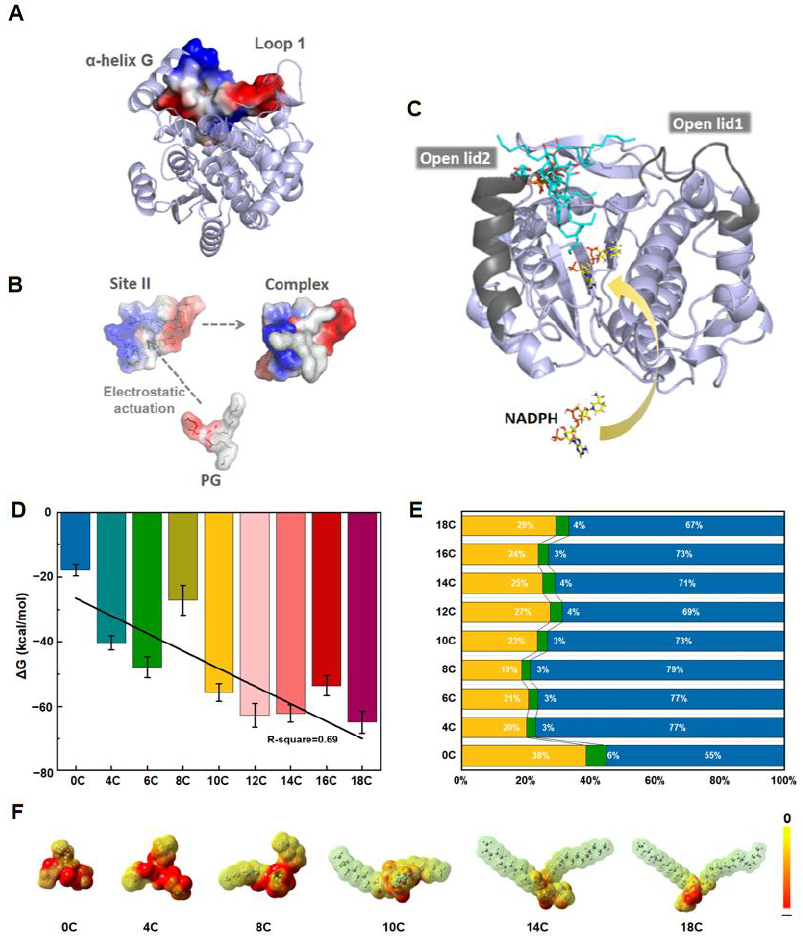
Figure 5. Electrostatic potential isosurface for ( A ) site II with the surrounding lid region, where red and blue represent positive and negative charges, respectively. ( B ) Schematic diagram of the electrostatic interaction driving PG to bind to site II. ( C ) PG (shown as cyan sticks) was captured to further promote the NADPH binding by affecting the lid conformation. ( D ) The total energy of LPOR binding PGs with different lengths. ( E ) Contribution of the energy term for favorable binding in nine systems (Ele: blue, Vdw: green, and Non-Pol: yellow, respectively). ( F ) The distribution of the electrostatic potential energy for different PG molecules on the electron density isosurfaces. The negatively charged nature of the PG head group caused the electrostatic potential energy of each part to be negative.